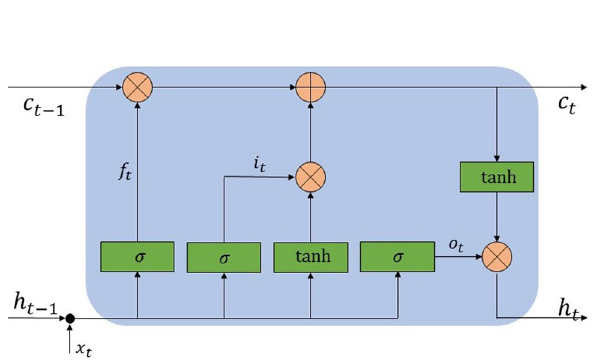
Fig. 18 LSTM unit structure